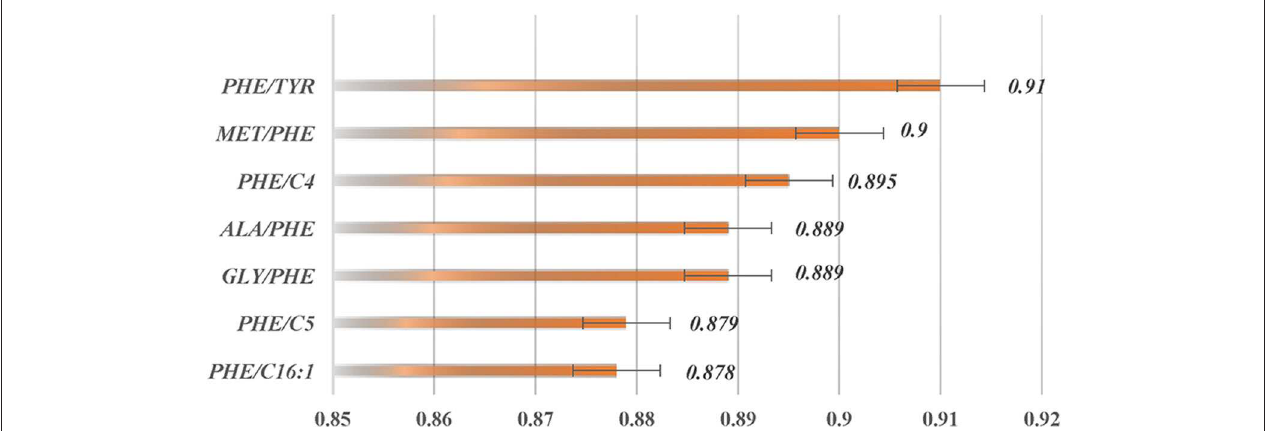
FIGURE 3 | Ranking of feature importance calculated by caret package in R utilizing LVQ analysis.